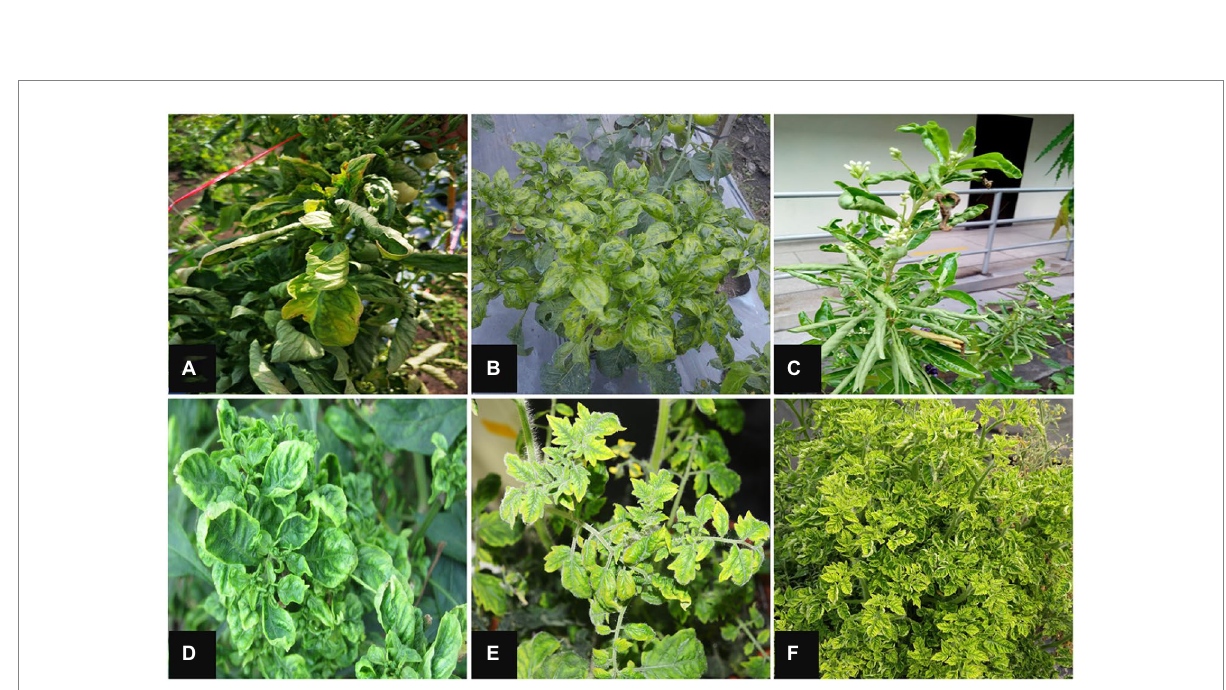
FIGURE 6 Symptoms of begomoviruses: (A) Tomato plant depicts the symptoms of Tomato yellow leaf curl Kanchanaburi virus ; (B) symptoms of Pepper yellow leaf curl Indonesia virus ; (C) papaya plants exhibit symptoms like yellowing, downward or upward curling, and vein thickening caused by Papaya leaf curl virus ; (D) symptomatic eggplant showing leaf curling caused by Tomato leaf curl Joydebpur virus ; (E) plant showing symptoms of Tomato yellow leaf curl Thailand virus ; and (F) Tomato yellow leaf curl virus causes symptoms like leaf yellowing, upward and downward leaf curling, and reduction in leaf